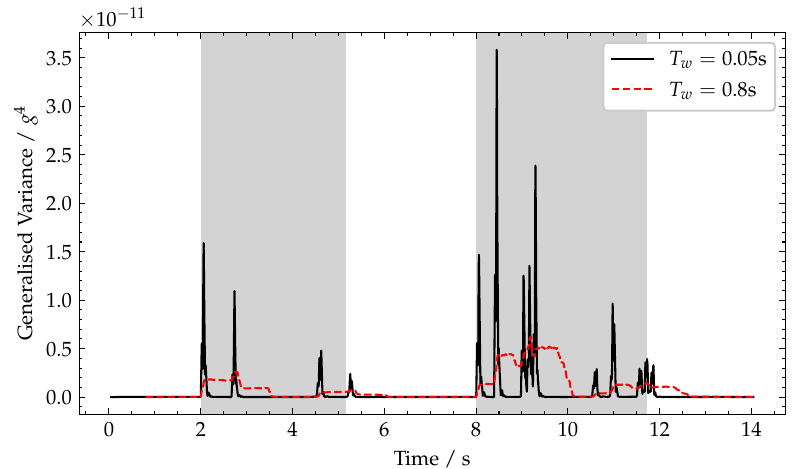
Figure 9. Plot of generalised variance for varying window lengths, T w . Periods when a vehicle is crossing the bridge are shaded grey.